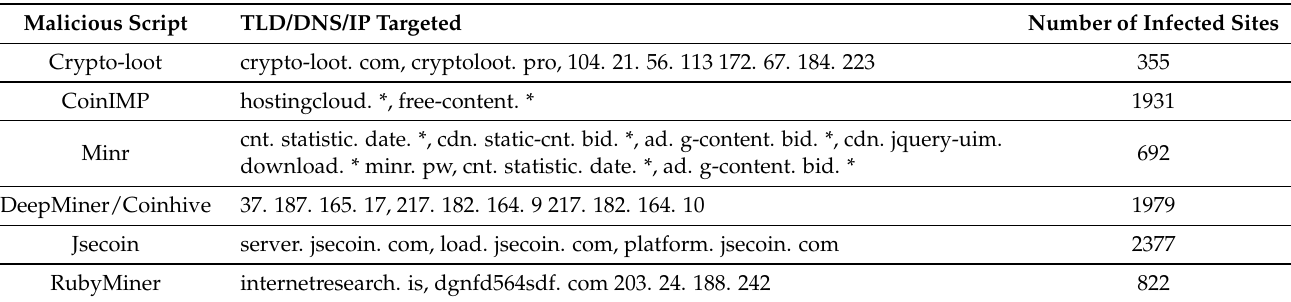
Table 2. Queries of malicious script patterns, top-level domains, and number of detected sites Malicious